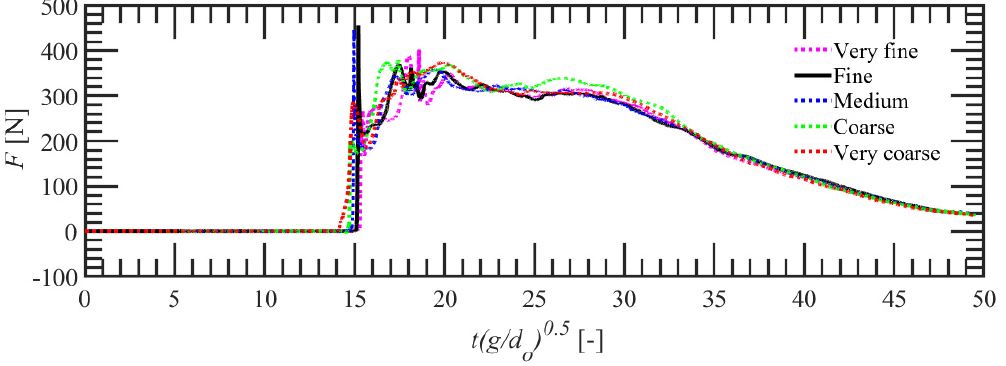
Figure A1. Effect of mesh density on the forces on the structure in the presence of the recurve wall (Wall 4) for d o = 0.9 m at L = 1